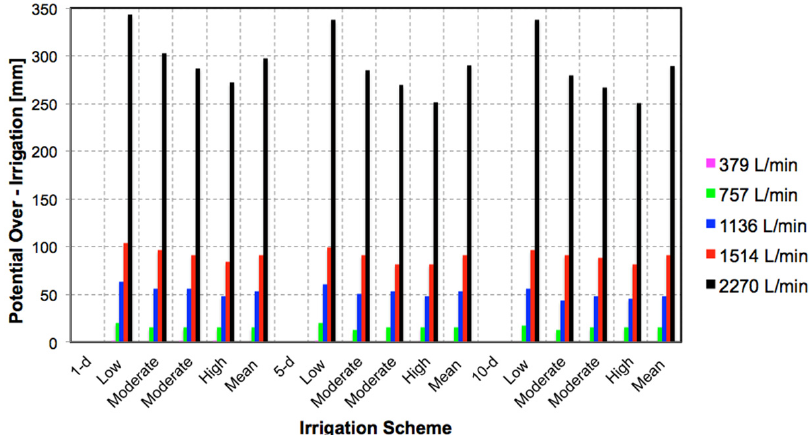
Figure 3. Potential over-irrigation amount (mm) as a function of irrigation scheme for the 1-day, 5-day and 10-day irrigation frequencies for Plainview, TX, USA. For each irrigation frequency, the potential over-irrigation amount is plotted as a function of well capacity.